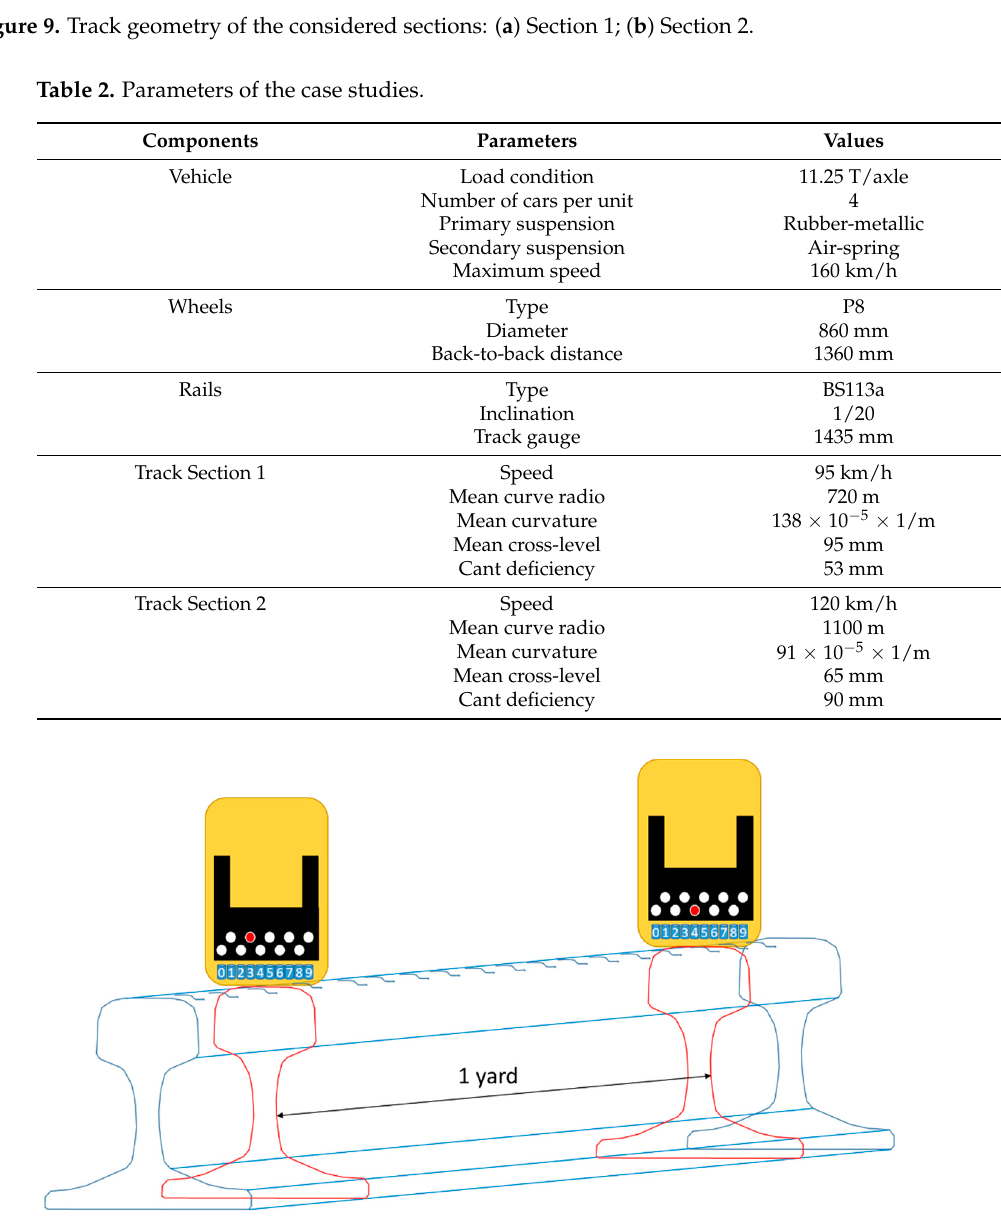
Figure 10. Sketch of Eddy Current measurement system on a rail.